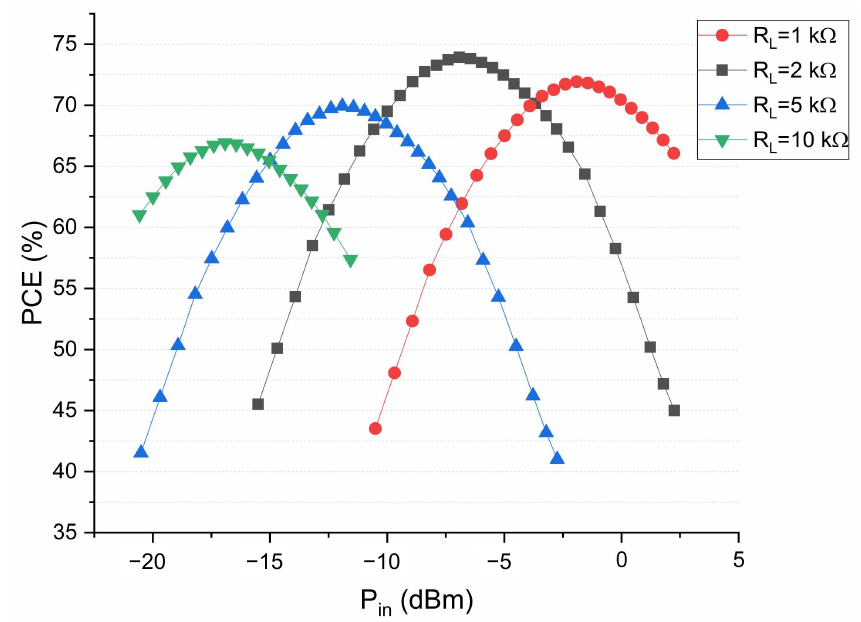
Figure 11. Power conversion efficiency (PCE) of cross coupled rectifier with different load impedances.